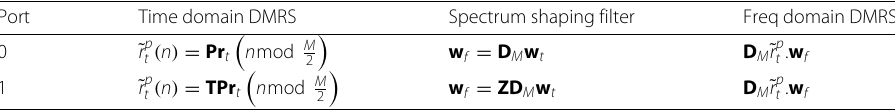
Table 1 Summary of method 1 based DMRS waveform generation Port Time domain DMRS Spectrum shaping